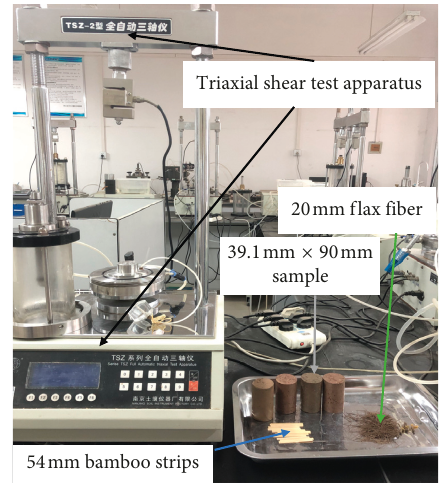
Figure 5: Samples